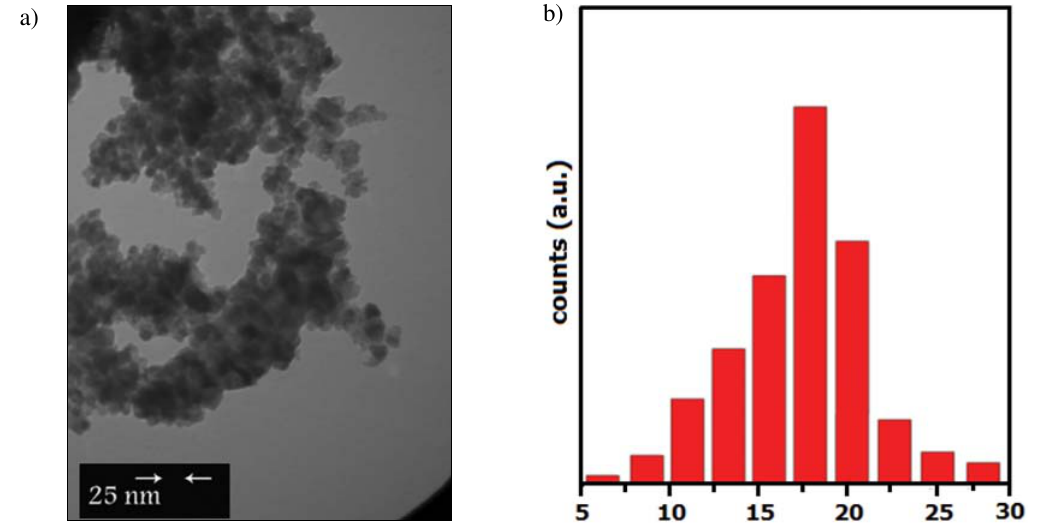
Figure 6. (a) TEM image of the Co